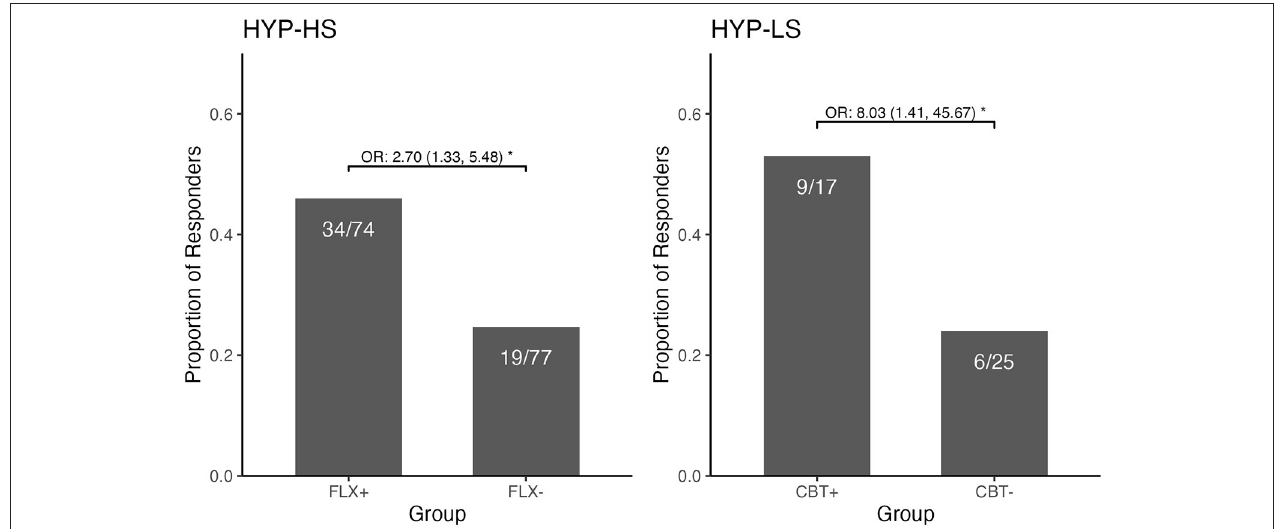
FIGURE 1 | Observed Responder Status and Odds Ratio for the Combined Fluoxetine Groups and the Combined CBT Groups among those with Hypochondriasis—High Somatic and those with Hypochondriasis—Low Somatic. The figure demonstrates two contrasting response profiles. Among the HYP-High Somatic participants, there was a significantly greater likelihood of being a responder if in the combined fluoxetine group than if in the combined group without fluoxetine. Conversely, among the HYP-Low Somatic participants, there was a significantly greater likelihood of being a responder if in the combined CBT group than if in the combined group not receiving CBT. * p <